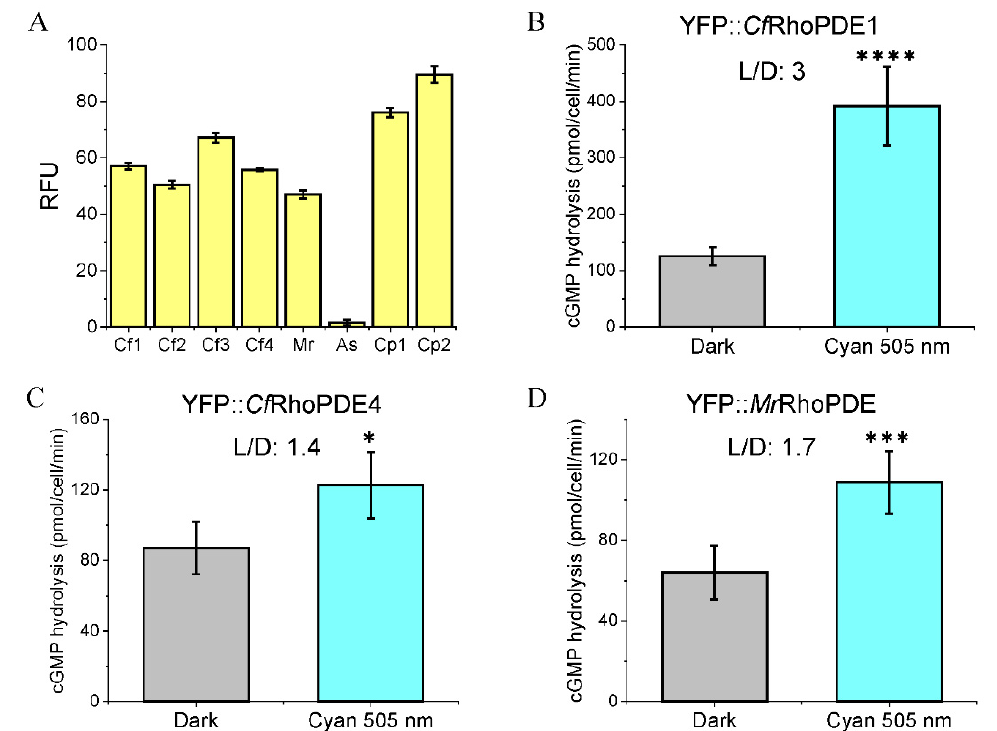
Figure 3. cGMP hydrolysis abilities of YFP:: Cf RhoPDE1, YFP:: Cf RhoPDE4 and YFP:: Mr RhoPDE. ( A ). The relative fluorescence unit (RFU) was measured from membranes of 3 oocytes for each construct. ( B ). cGMP hydrolysis activities of YFP:: Cf RhoPDE1. ( C ). cGMP hydrolysis activities of YFP:: Cf RhoPDE4. ( D ). cGMP hydrolysis activities of YFP:: Mr RhoPDE. For ( B – D ), all activities were